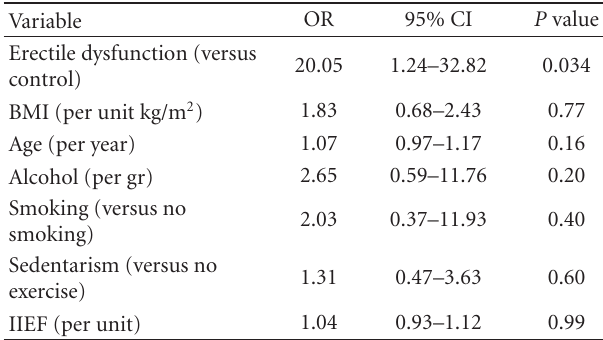
Table 2: Binary logistic regression model for metabolic syndrome (dependent